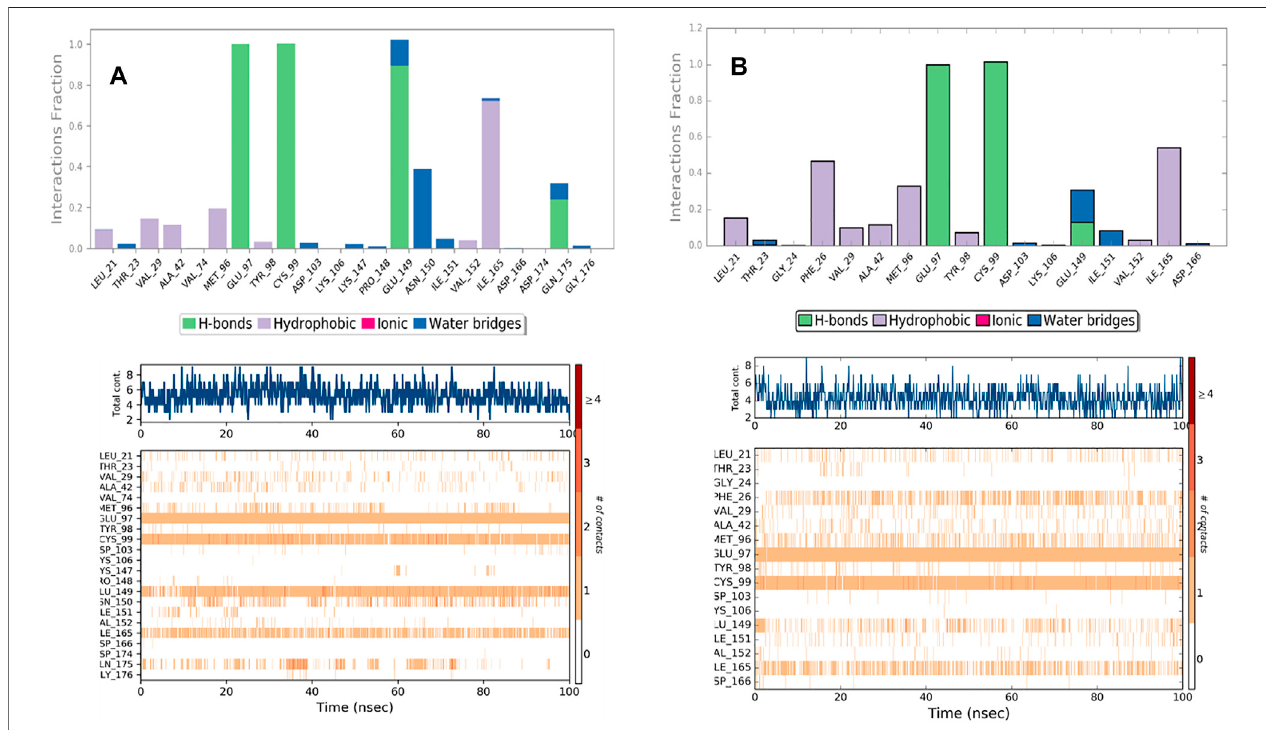
FIGURE 8 | Protein-Ligand contacts: K252a in Chain A (A) K252a in Chain B (B) .